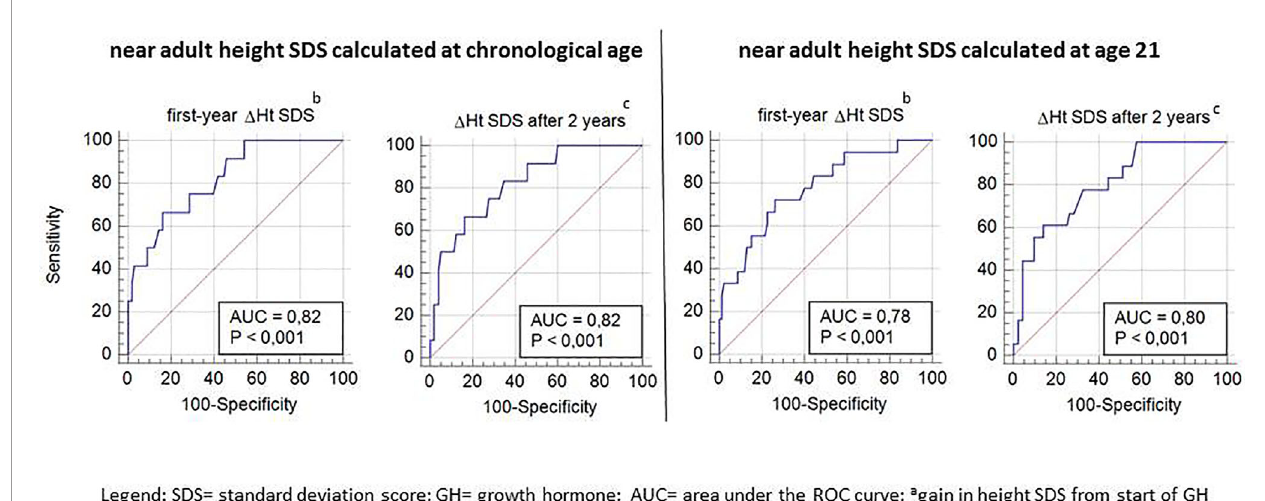
FIGURE 3 | ROC curve analysis for D height SDS after the fi rst and second prepubertal GH treatment years, with its sensitivity and speci fi city to predict total D Ht SDS <1.